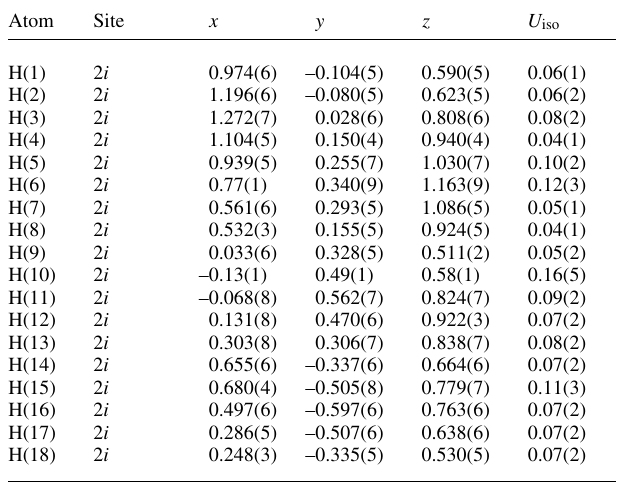
Table 1. Data collection and